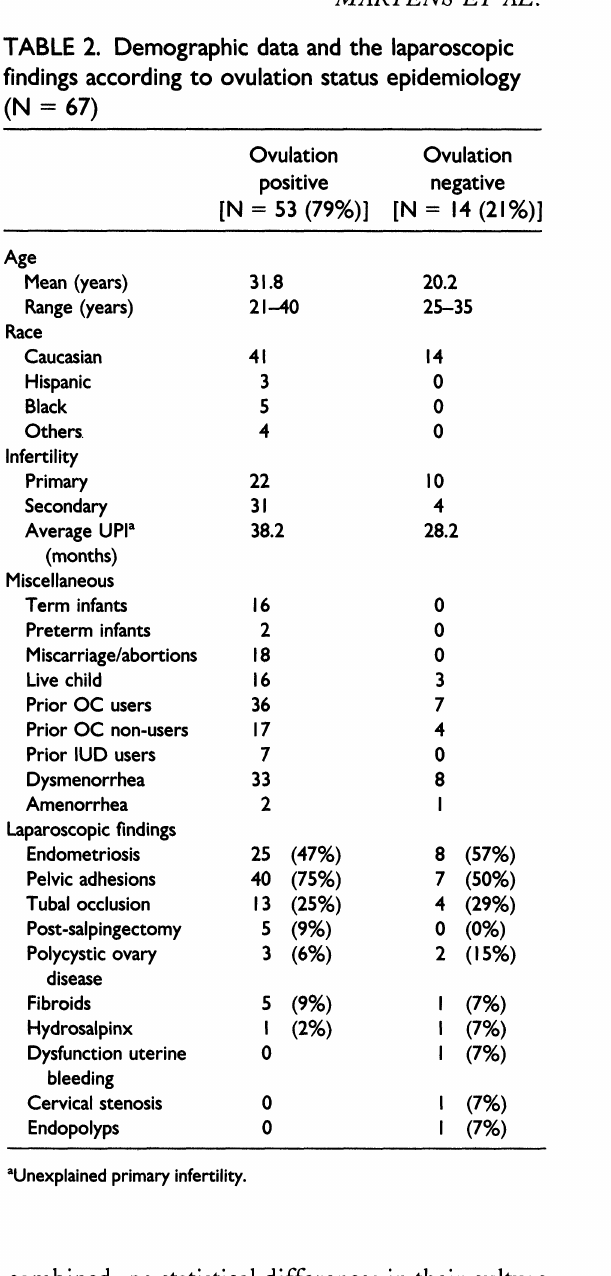
TABLE I. Demographic data of infertile and pregnant control groups